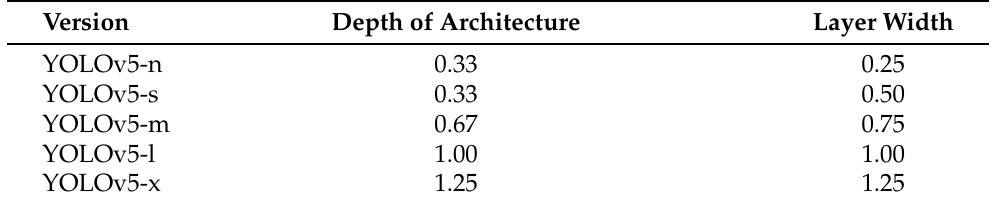
Table 4. YOLOv5 versions.